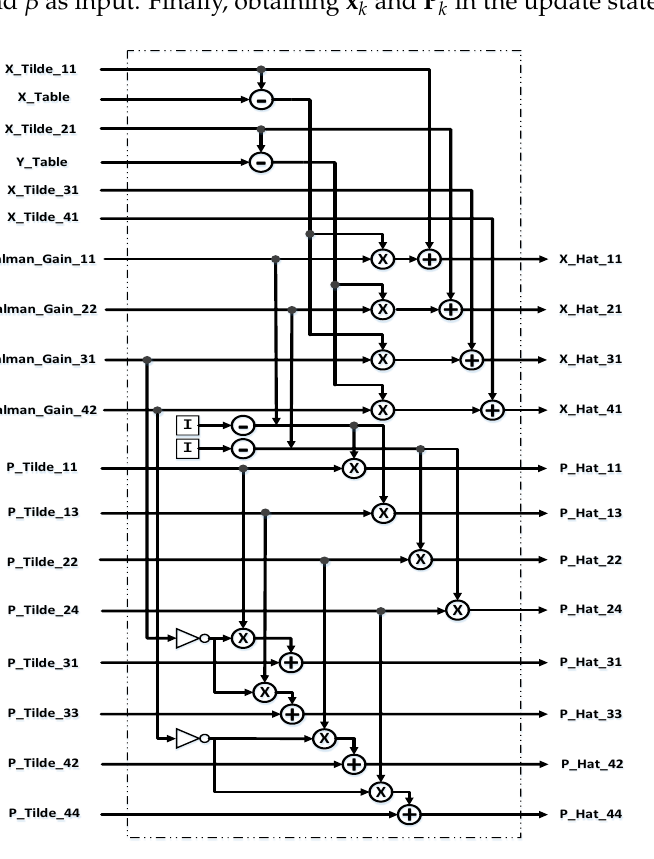
ˆ P in the update state module. and k